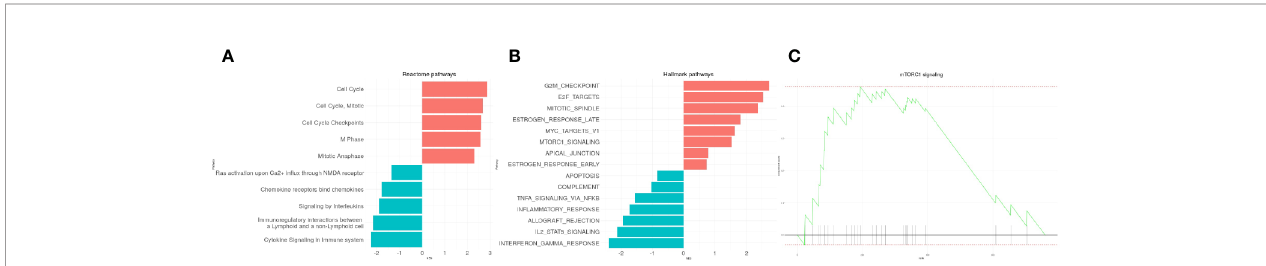
FIGURE 2 | Visualization of enriched reactome and hallmarks genes sets in T-cell Acute Lymphoblastic Leukemia (T-ALL)-cDEG. The 10 top enriched reactome (A) and hallmark (B) gene sets are presented. (C) Enrichment plot of the mTORC1 signaling pathway.